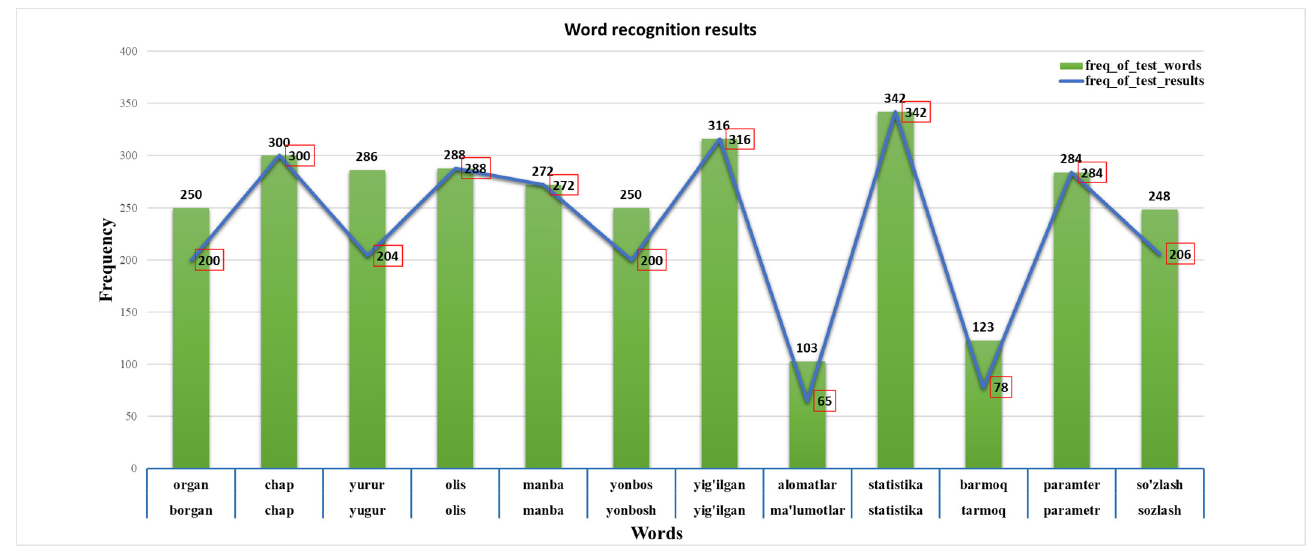
Figure 7. The experimental results of the proposed model on word recognition in the Uzbek language. Some words have more than 50 frequency errors.